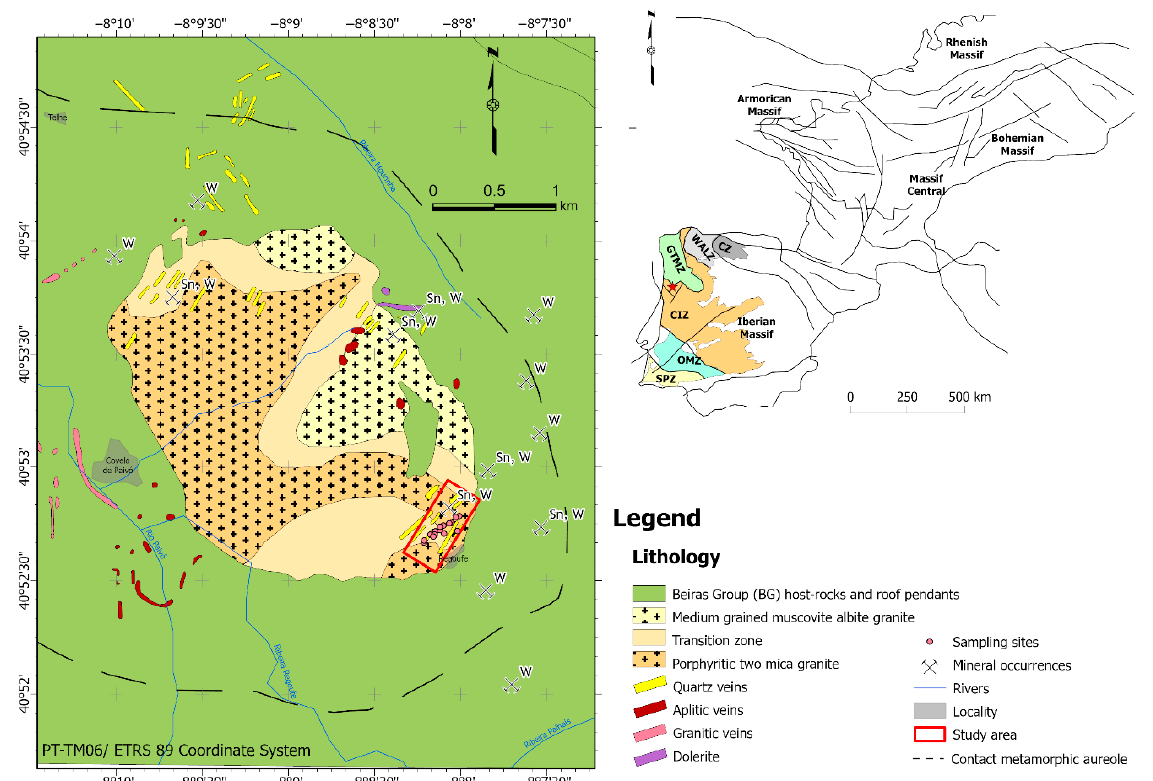
Figure 1. Geological sketch of the Iberian Variscan belt simplified. CZ—Cantabrian Zone, WALZ— West Asturian Leonese Zone, GTMZ—Galicia Trás-os-Montes Zone, CIZ—Central Iberian Zone, OMZ—Ossa Morena Zone, SPZ—South Portuguese Zone (based on [7,8]). Geological map of the Regoufe area modi fi ed from [15] and location of the study area.